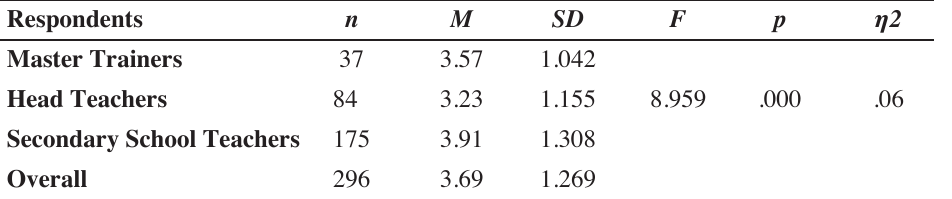
Table.2 Use of information and communication technology has a positive effect on teaching